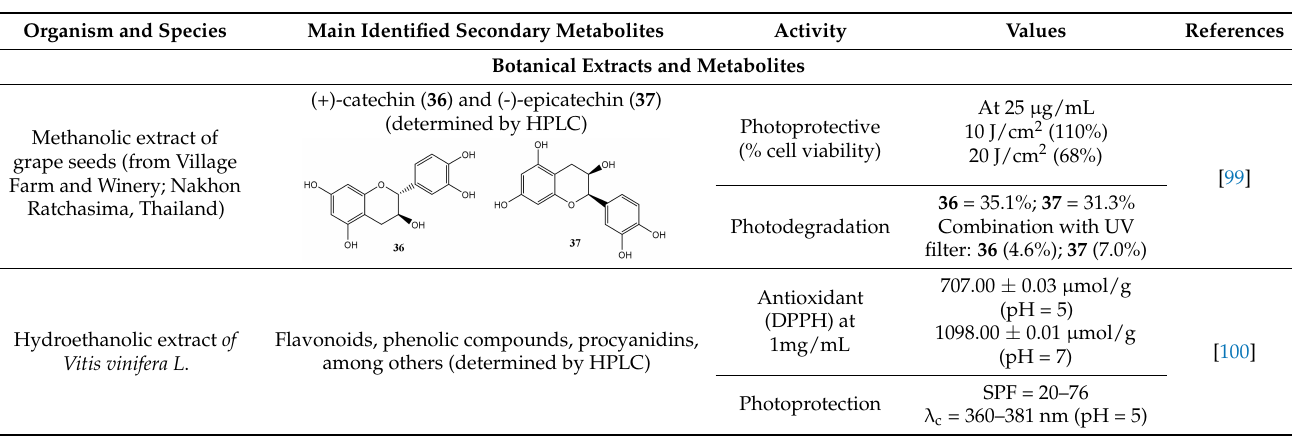
Table 3. Natural extracts and metabolites of botanical and marine sources with photoprotective and antioxidant